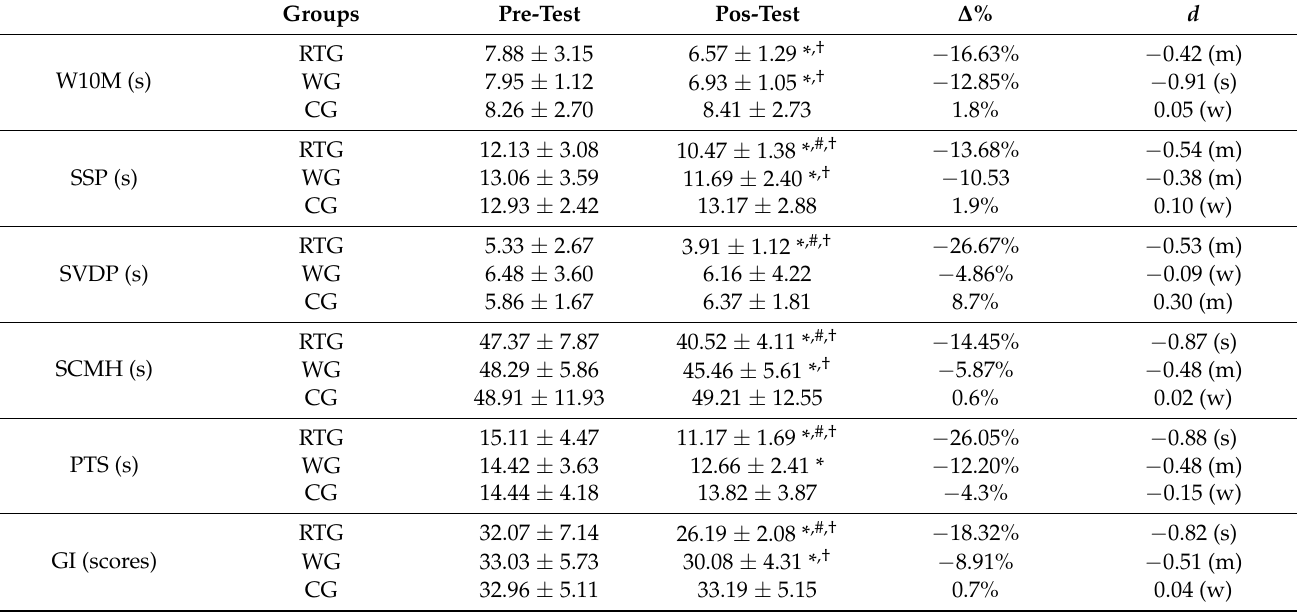
Table 3. Comparative analysis of the autonomy tests between the study groups.